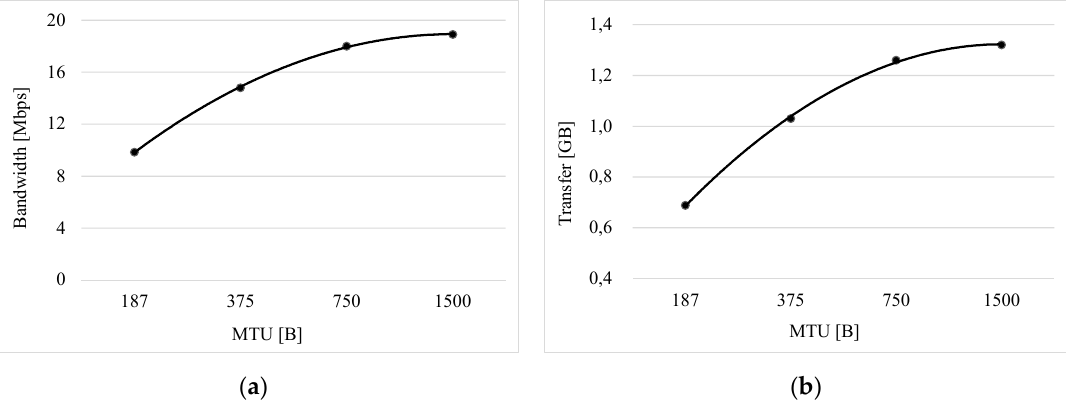
Figure 7. Dependency of packet length: ( a ) Network bandwidth; ( b ) Network transfer.